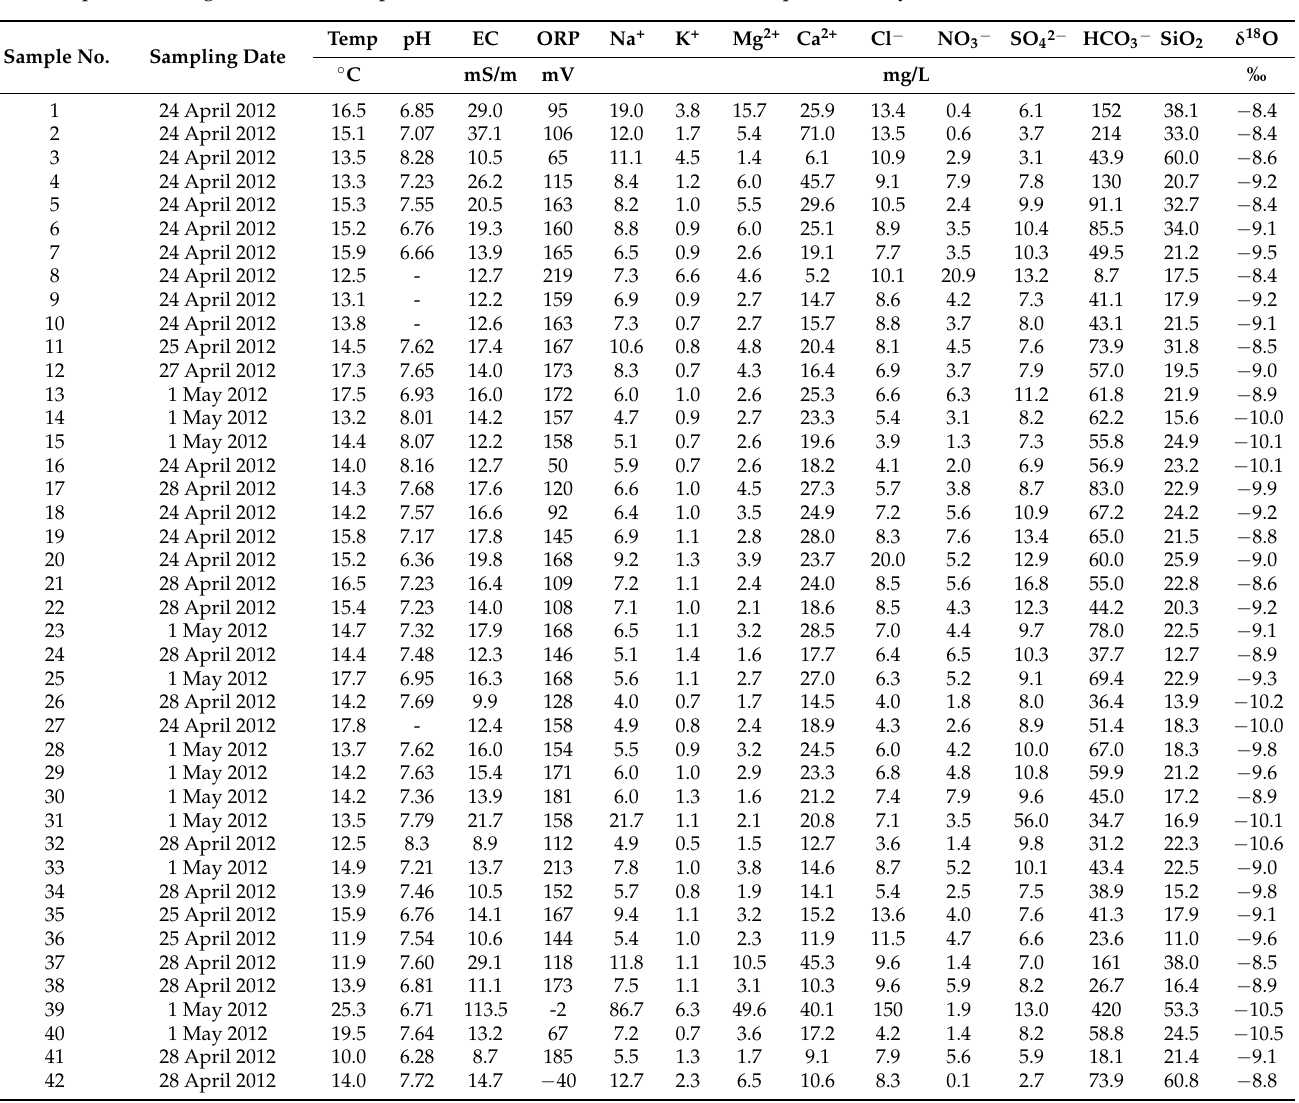
Table 3. Water temperature, pH, electric conductivity (EC), oxidation–reduction potential (ORP), chemical, and δ 18 O composition for groundwater samples in the Sho River alluvial fan on 24 April to 1 May 2012. Sample